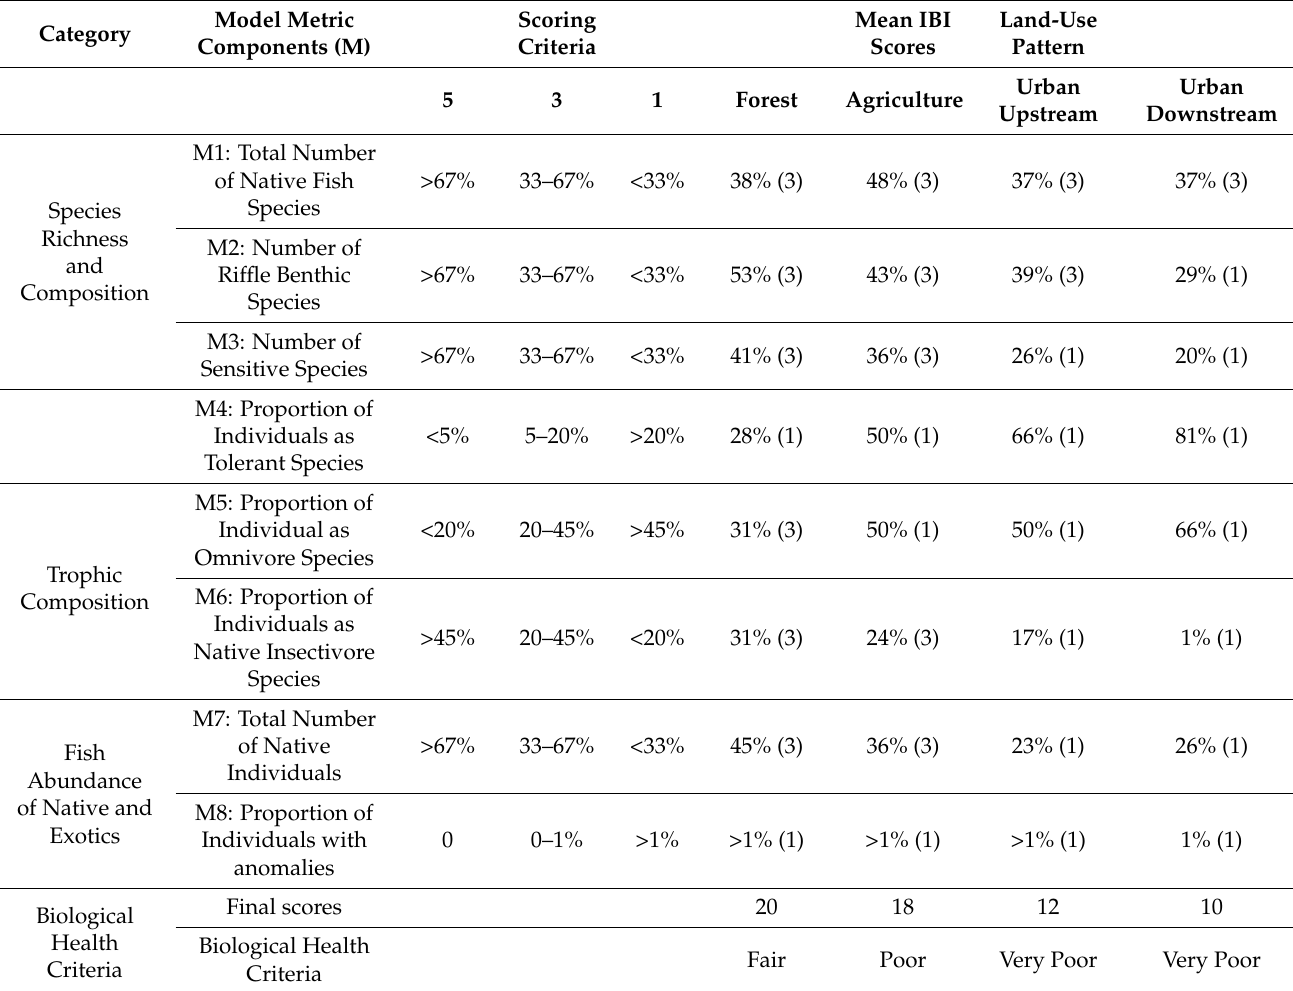
Table 2. Biological health assessment using the IBI model based on the four land-use patterns, including forest, agriculture, urban up, and downstream